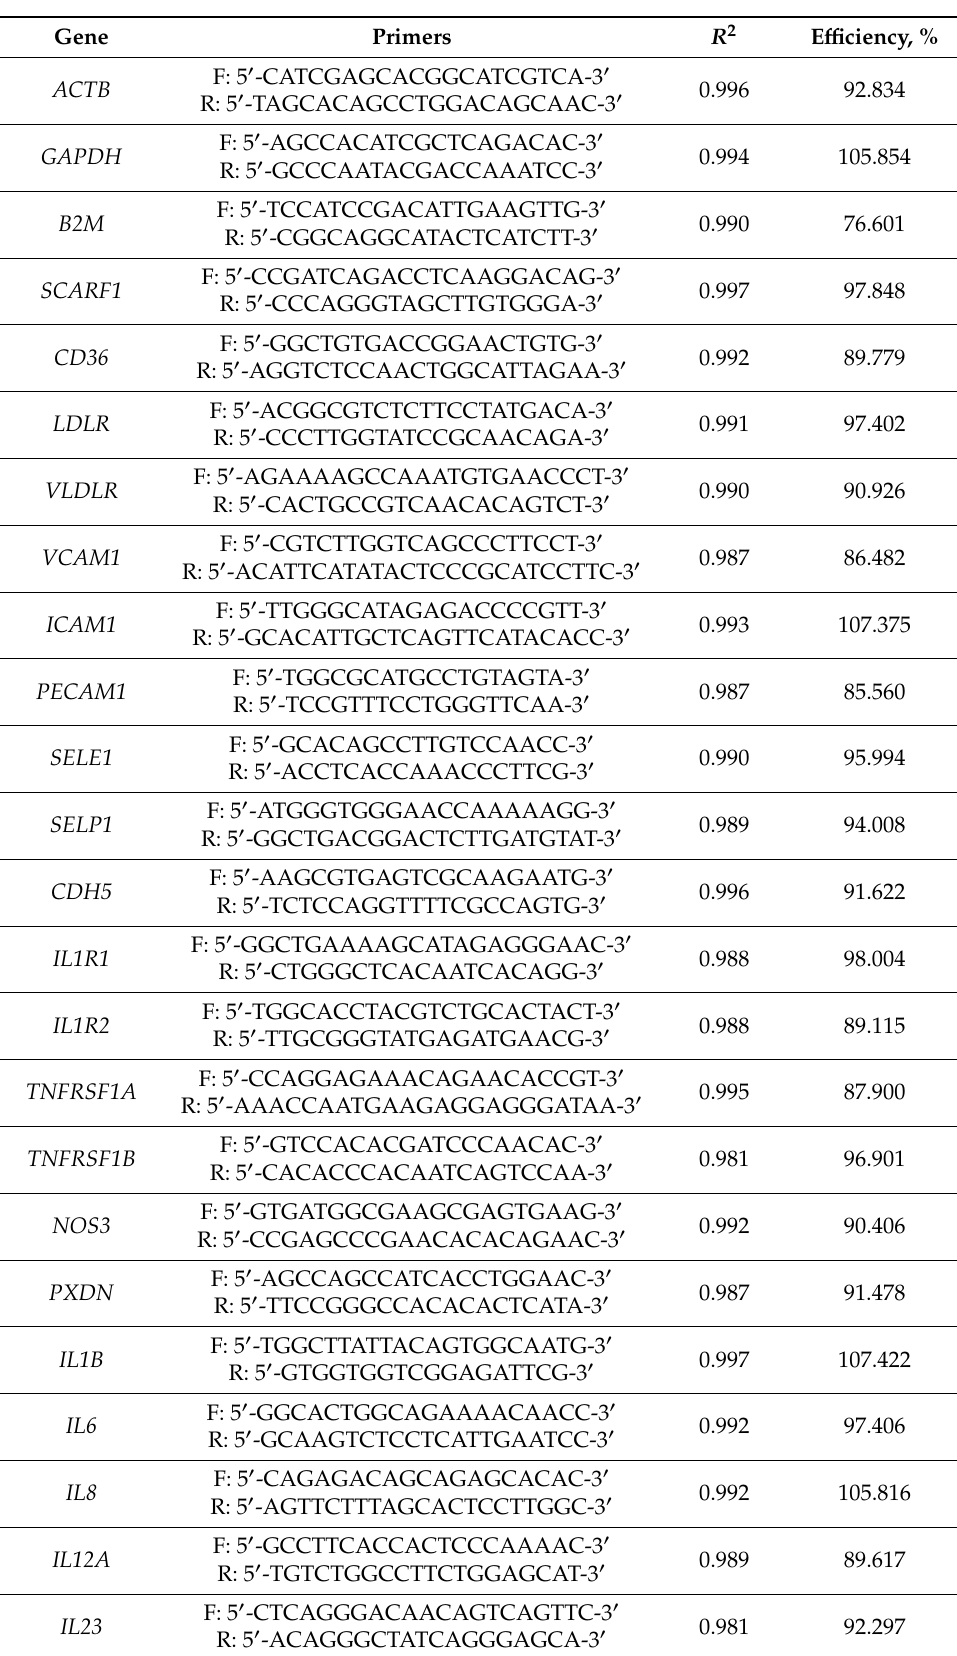
Table 1. Primers for qPCR and parameters of the